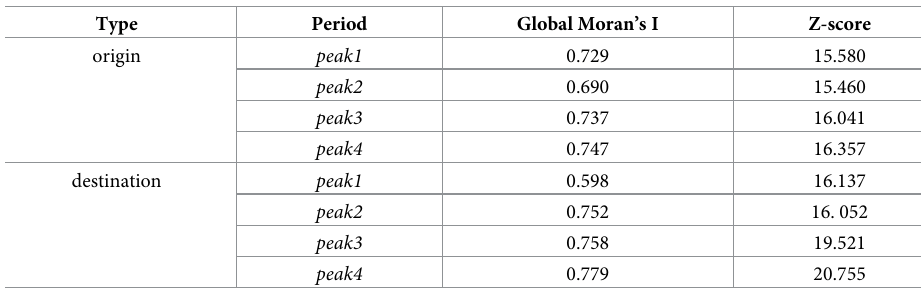
Fig 7. Hotspots of peak3 and peak4 . a) peak3 origin; b) peak3 destination; c) peak4 origin; d) peak4 destination. https://doi.org/10.1371/journal.pone.0259694.g007 (Fig 9). The spatial distribution of taxi destinations is wider than origin. It can be inferred that taxis tend to carry passengers in the central area of Manhattan and drive them to the far peripheries. Table 2. Results of global Moran’s